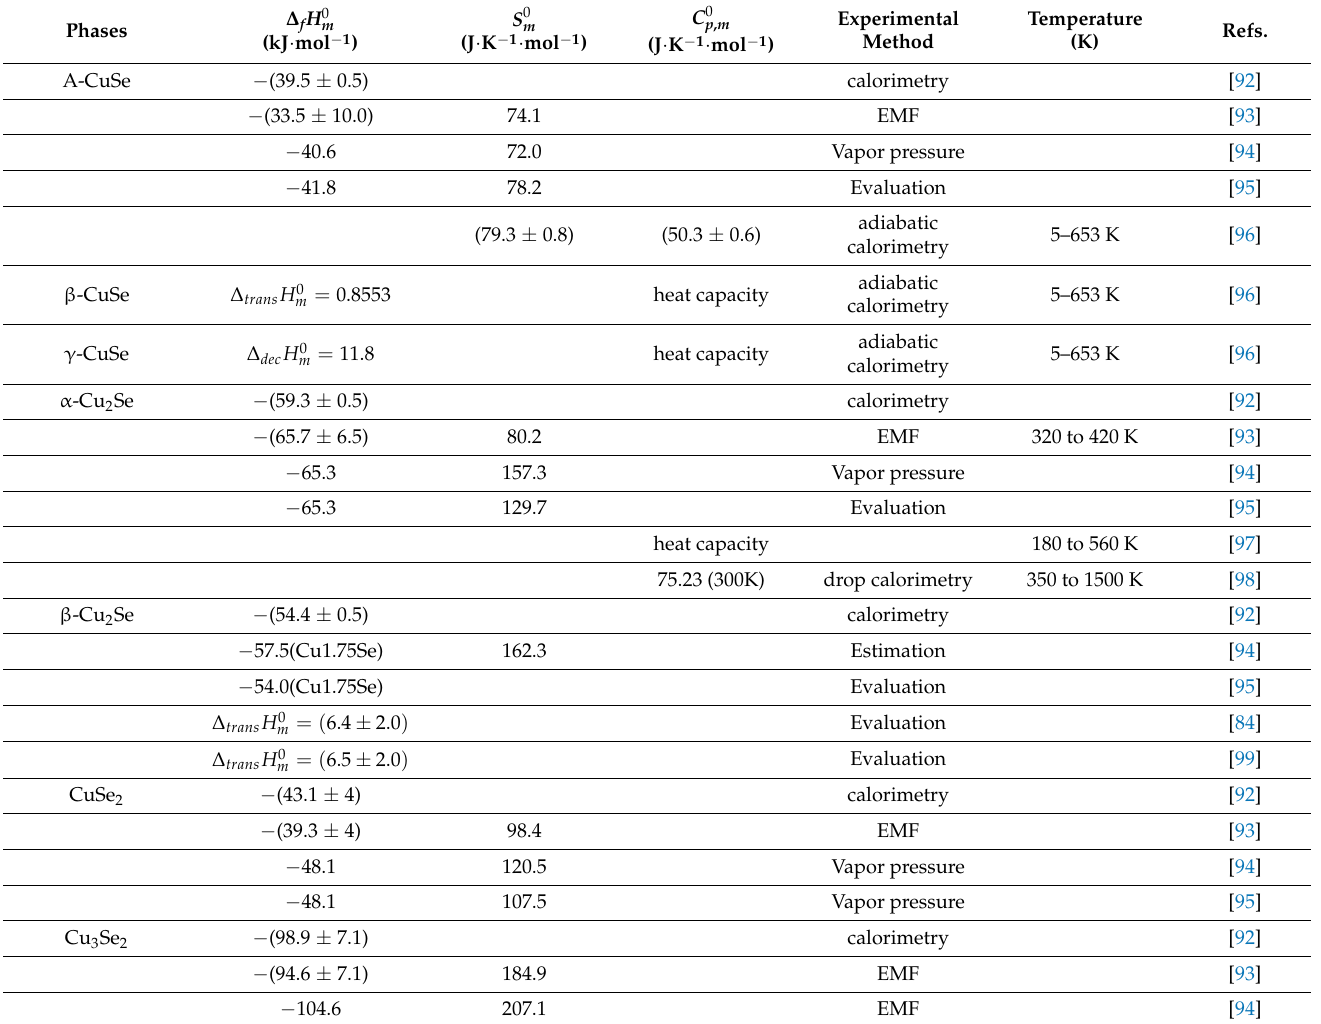
Table 2. Summary of the original experimental work [84,93–100] on the thermodynamic properties of the Cu-Se system at 298.15